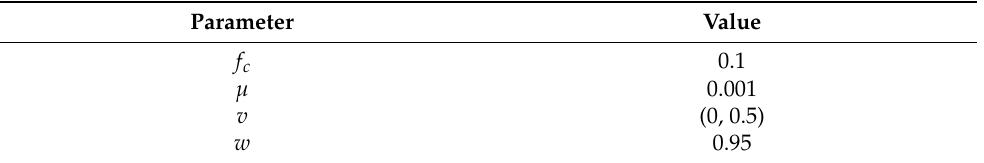
Table 1. Setting of experimental